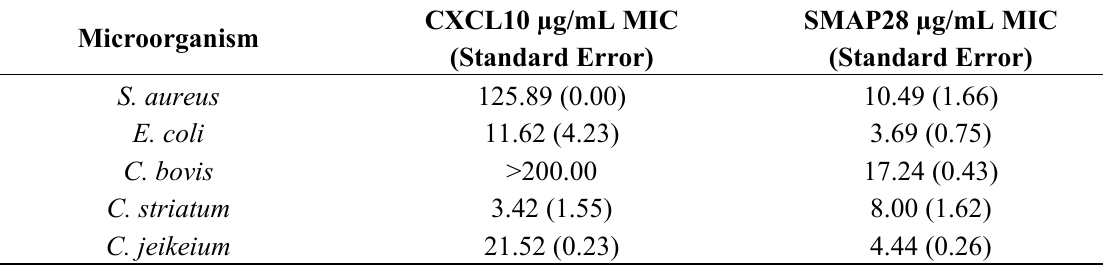
Table 2. Radial diffusion assays showing the minimal inhibitory concentration (MIC) of CXCL10 for microorganisms commonly found as commensals or pathogens on the